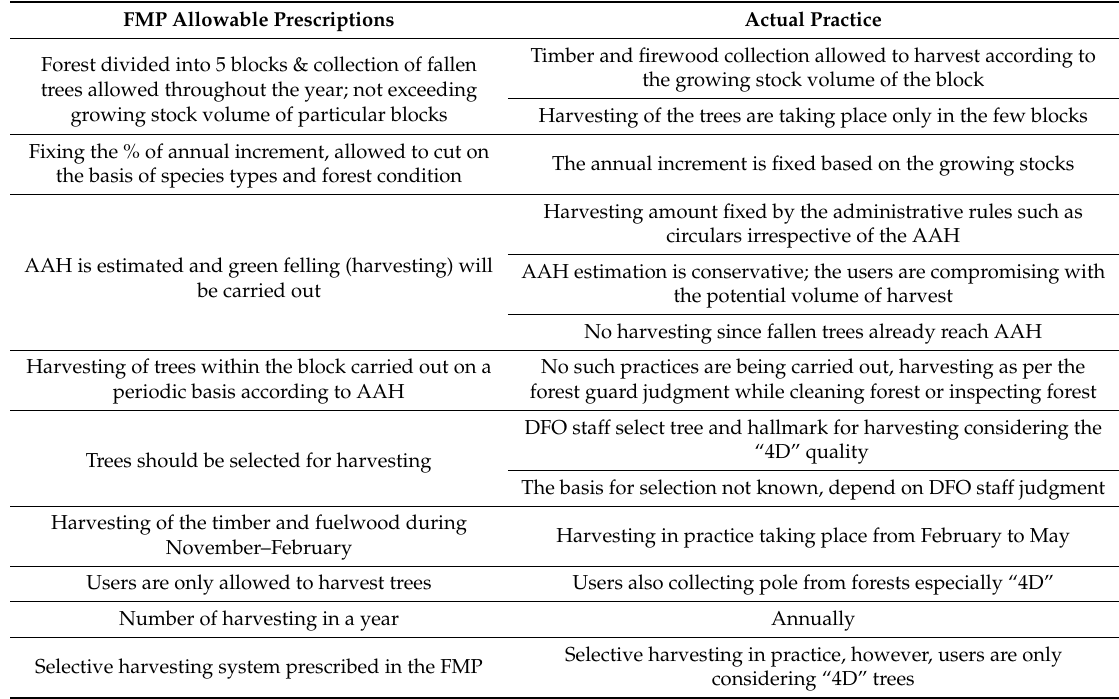
Table 3. Observed deviations of forest management practices with reference to the